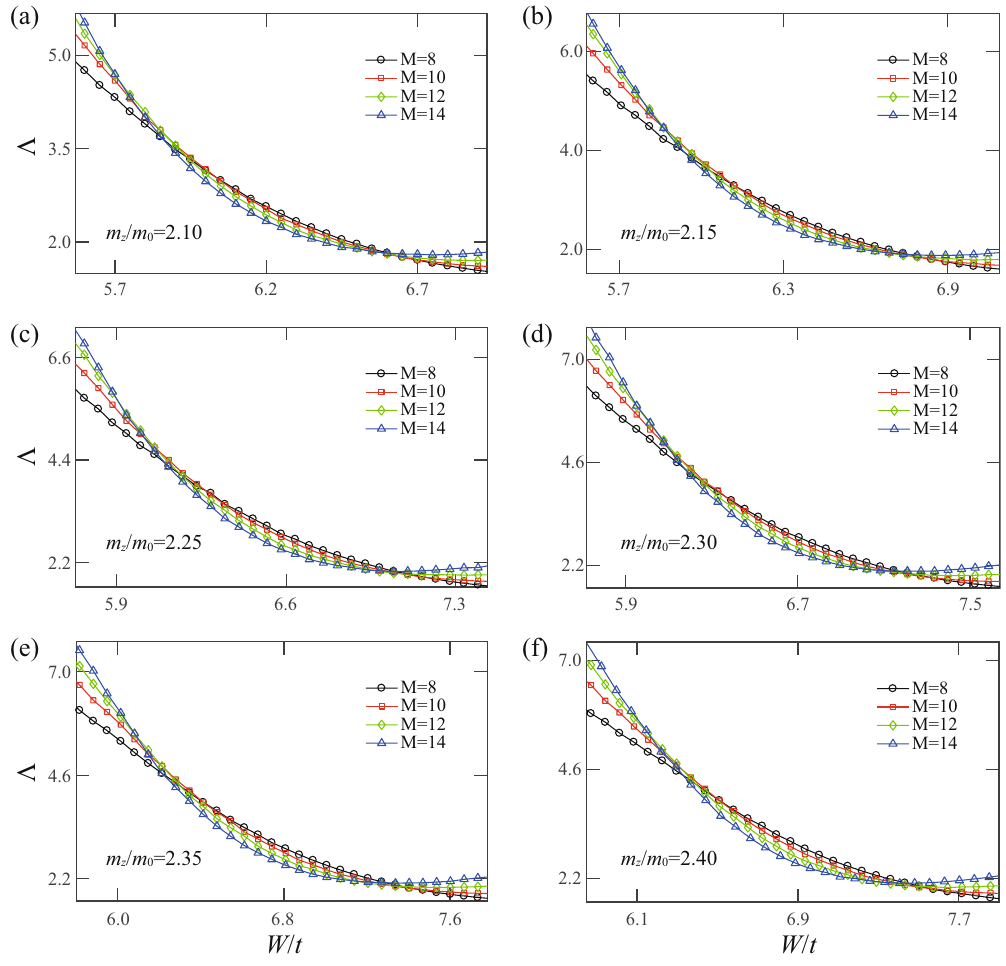
Figure 2. ( a – f ) The normalized localization length as a function of W t / for = . m m / 2 10 2.40, respectively. = E 0 and = . m t 2 1 are F 0